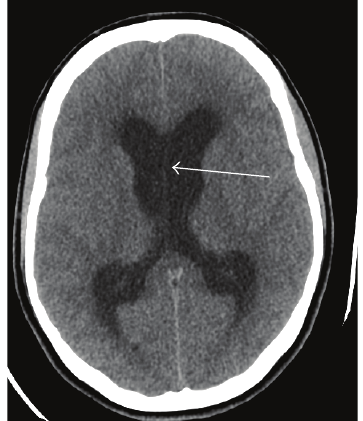
Figure 1: Plain axial CT scan of brain-showing severe obstructive lateral ventricle hydrocephalus shown by white arrow with signs of brain edema.